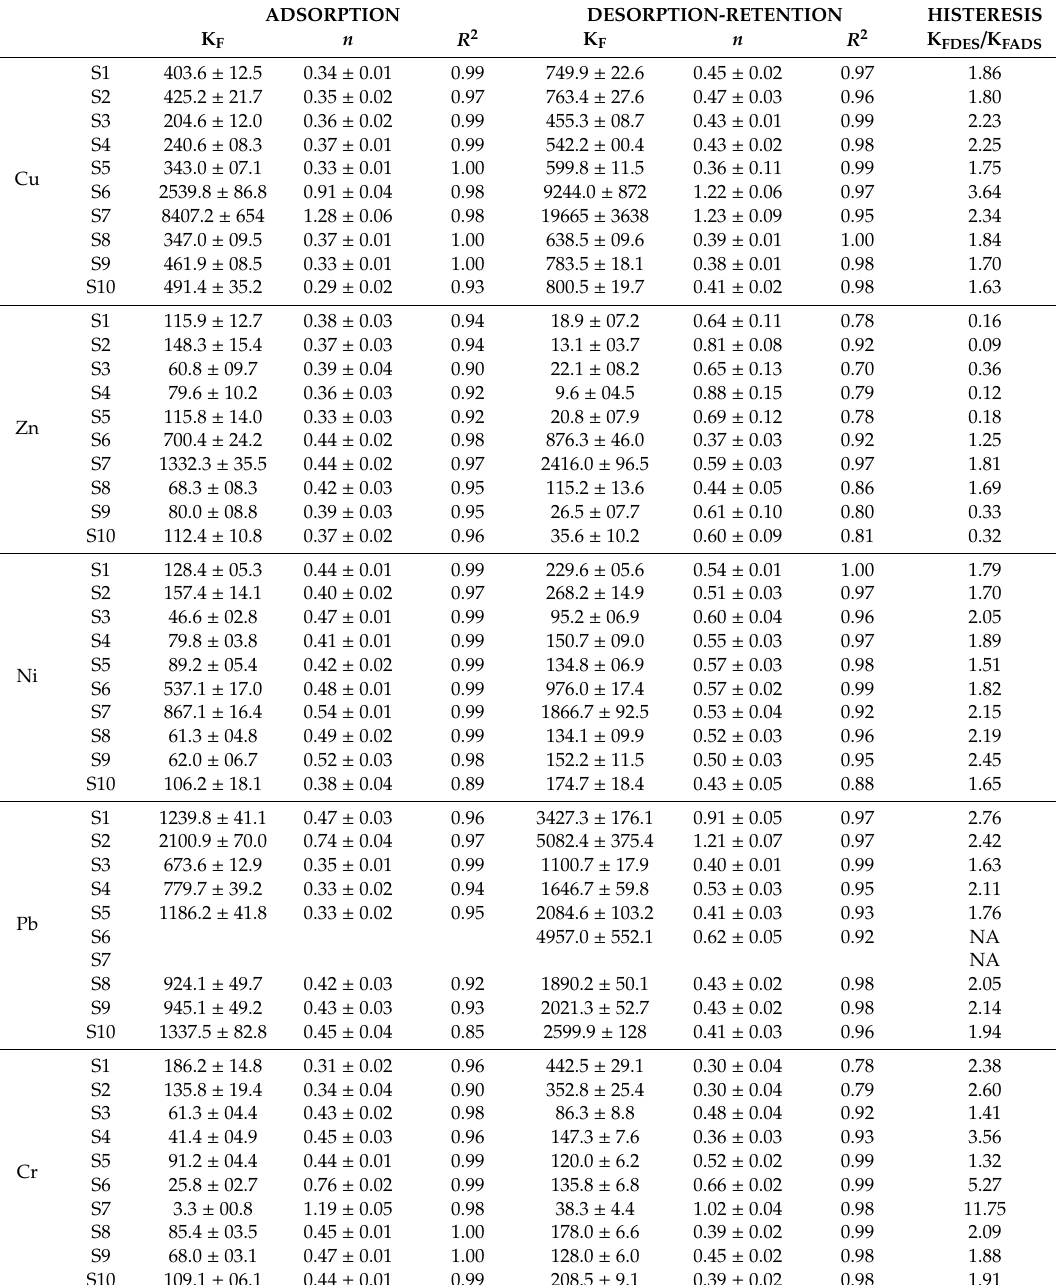
Table 2. Results derived from Freundlich model: K F (L n mg 1 − n kg − 1 ), n (dimensionless) and R 2 values from individual adsorption and desorption